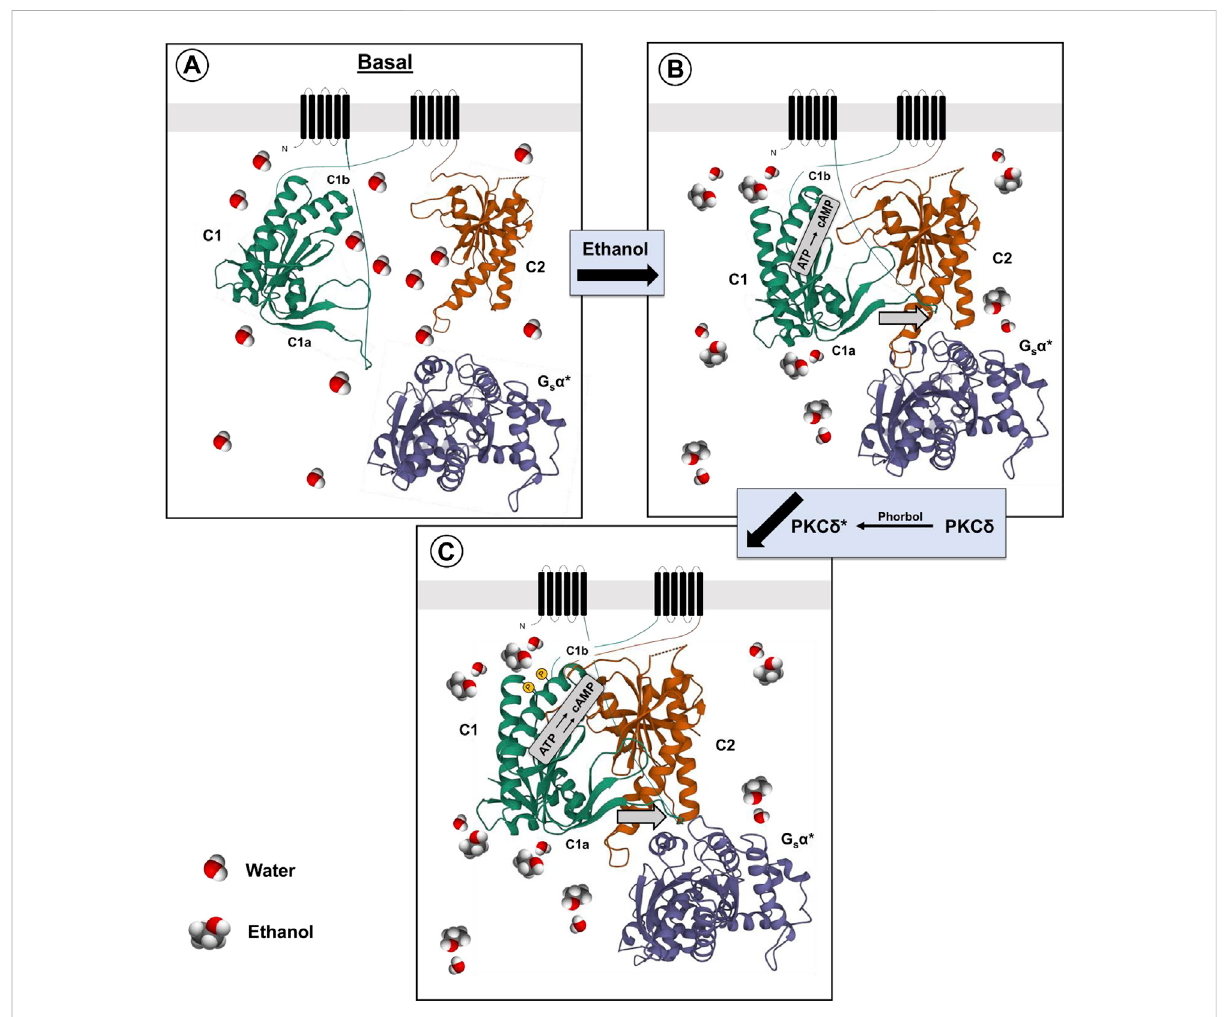
FIGURE 1 Proposedmechanism forethanolpotentiationofG α s-mediated activation ofAC7 (A,B) .Thepresenceofethanolinthewaterlayerimmediately adjacent to the C1a, C1b and C2 domains (Bagchi, 2005) promotes the alignment of these domains and interaction with G α s (Yan et al., 1996) (C) . Further modi fi cation of the secondary or tertiary structure of the C1b domain can promote access to this region by PKC δ (protein interaction) and phosphorylation of AC7, further enhancing G α s-mediated activation of AC7 enzyme